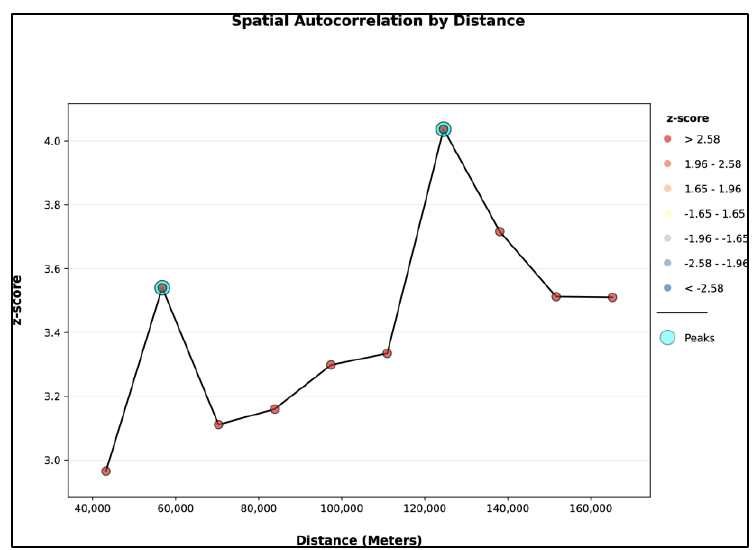
Figure 6. Incremental spatial autocorrelation (Global Moran’s I statistics) analysis results of the knowledge score.